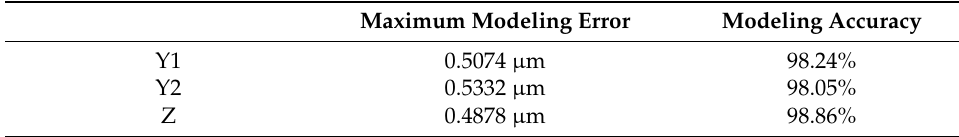
Table 3. Modeling error and accuracy of each axis of 3D-EVC